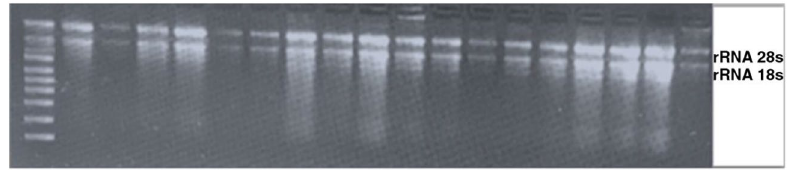
Figure 8. An example of the total RNA extracted of the S. striata